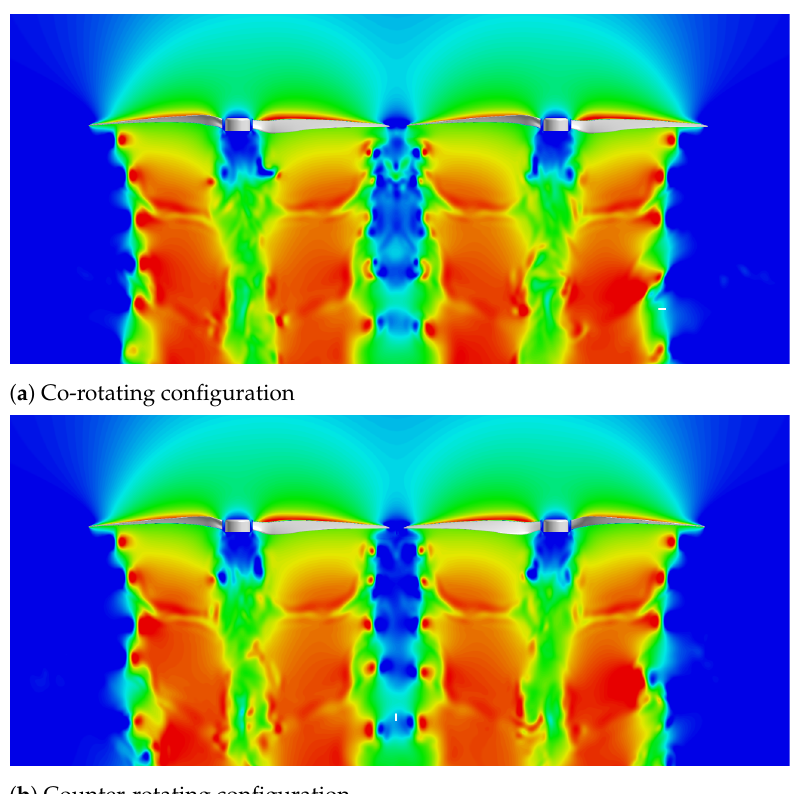
Figure 13. Instantaneous planar slice of downward vertical velocity along the centerline of the mesh system at the final time step for the dual rotor configuration with t = 0.04 D